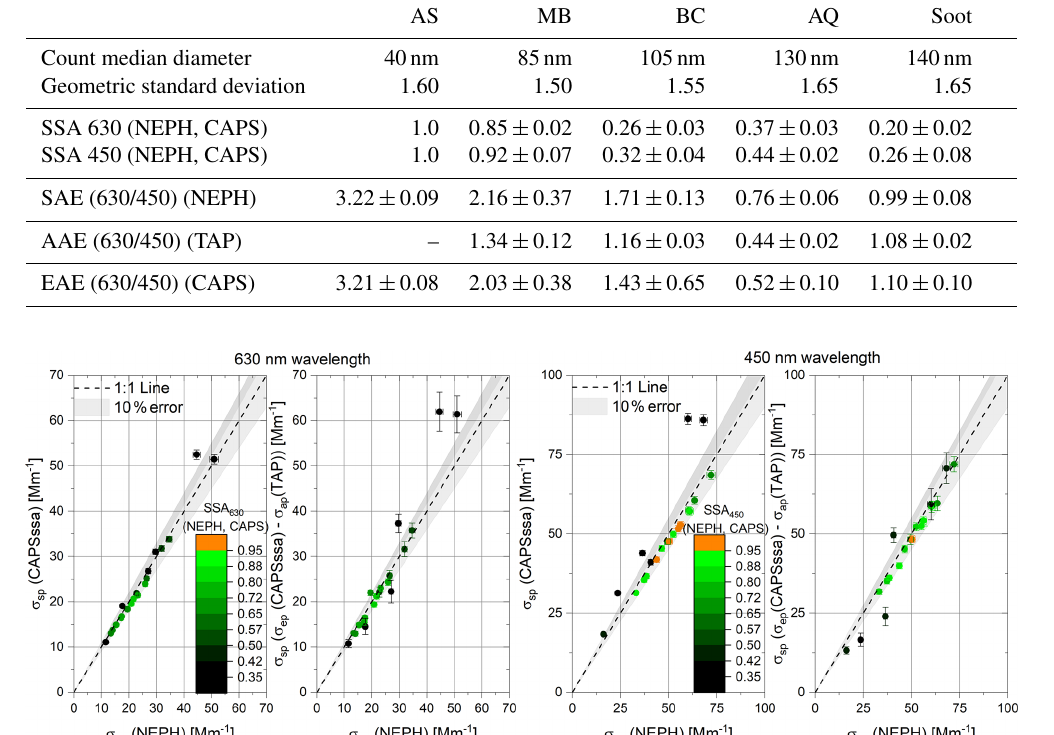
Figure 4. Comparisons of measured light-scattering coefficients at 450 and 630nm wavelengths for mixtures of AQ and AS aerosols. The y axes show the CAPS PM SSA (integrating sphere) or the differential method (CAPS extinction minus TAP absorption) scattering versus NEPH scattering measurements at 450 and 630nm wavelengths. The colour code represents the SSA value of the measured aerosol mixture. An error band of ± 10% was applied to the 1 : 1 line. Error bars shown represent instrument precisions (1 σ ).